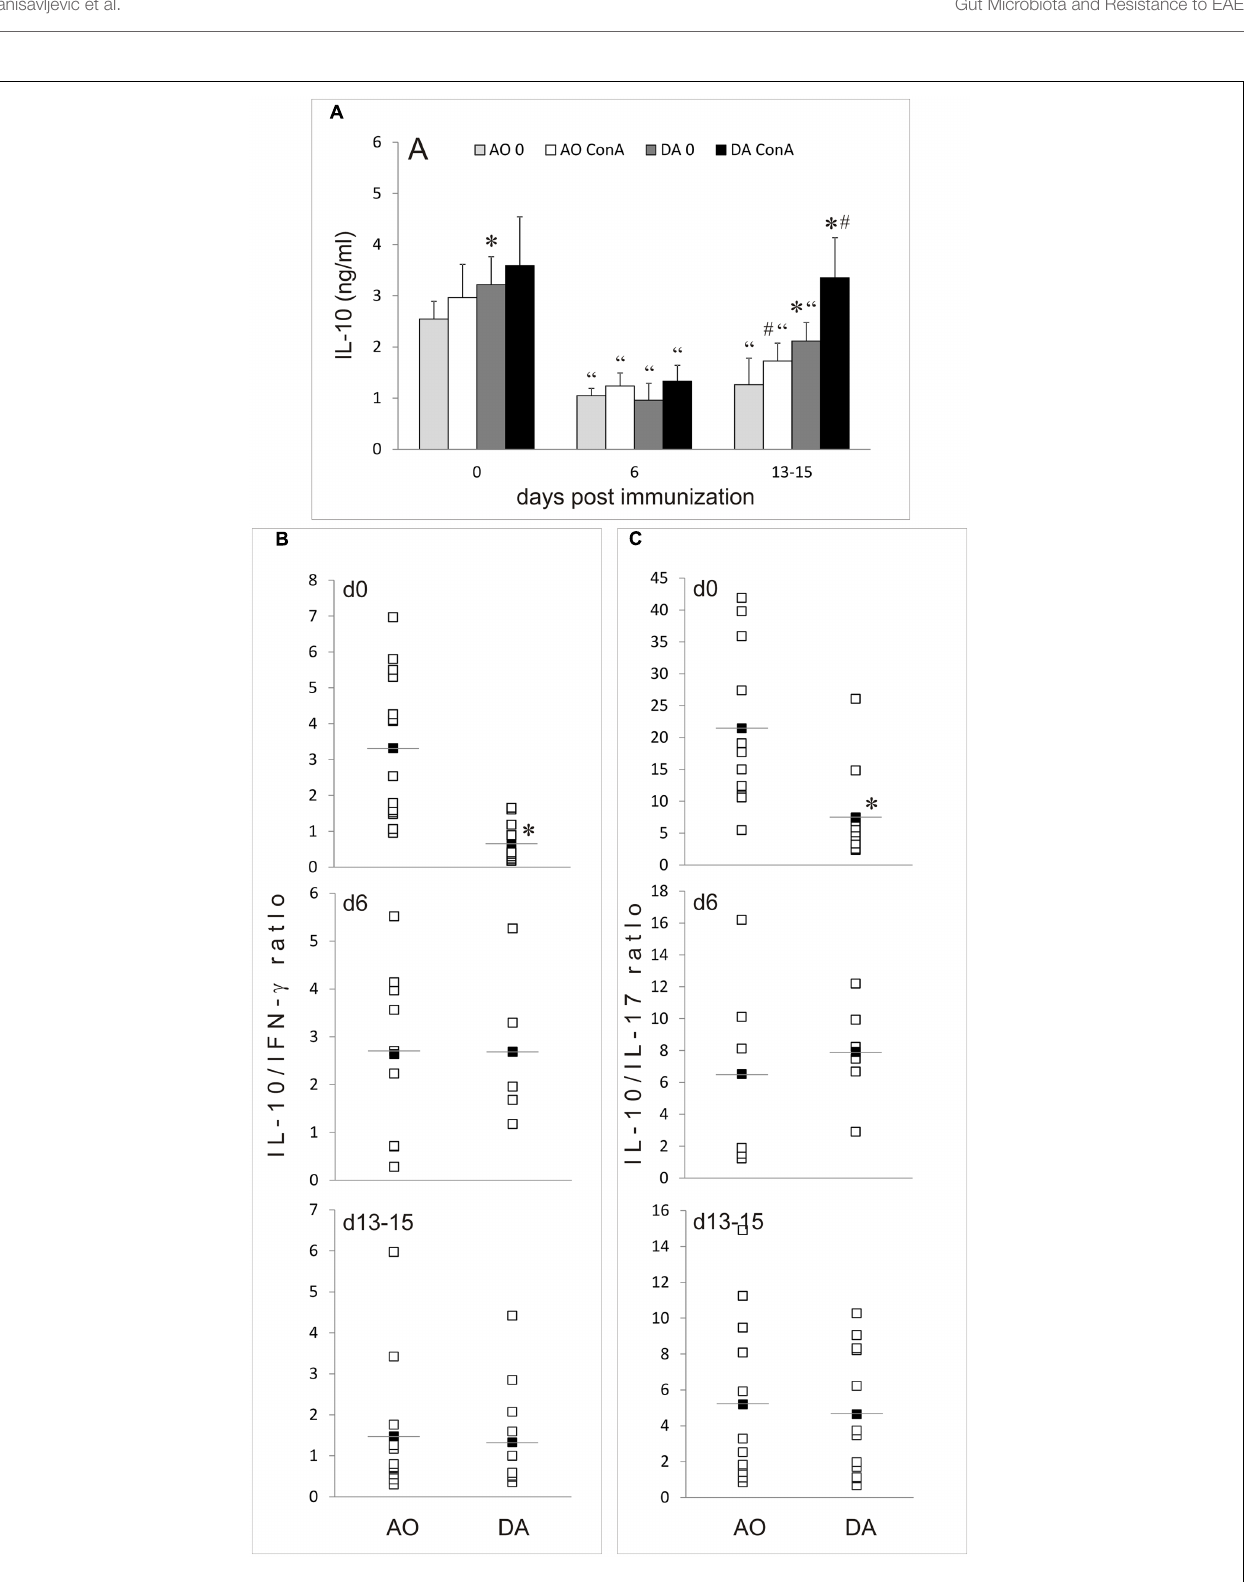
Frontiers in Microbiology |